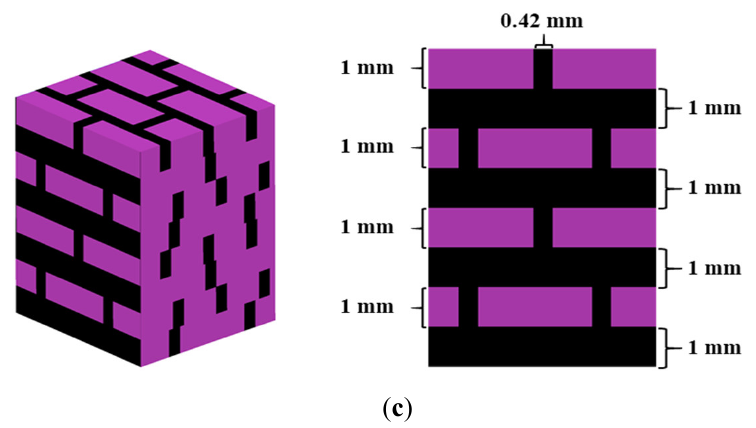
Figure 4. Schematic diagram of typical unit cell: ( a ) Bio-S; ( b ) Bio-B; ( c ) Bio-N.